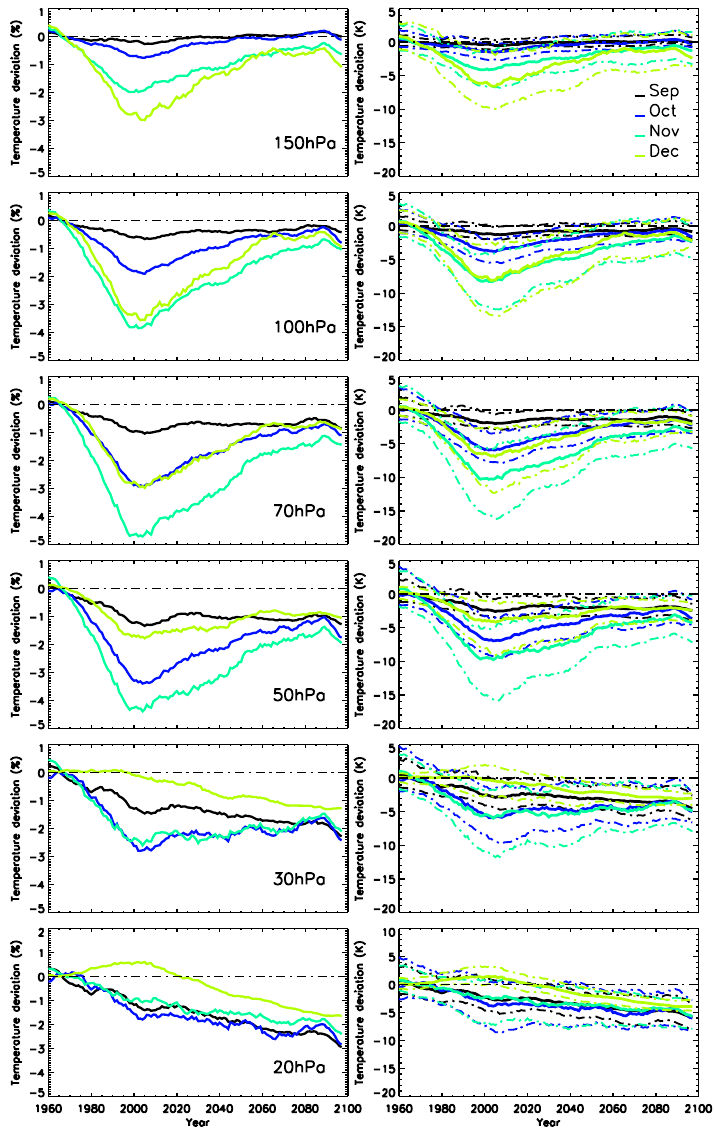
Fig. 6. Same as in Fig. 5, but for multi-model median